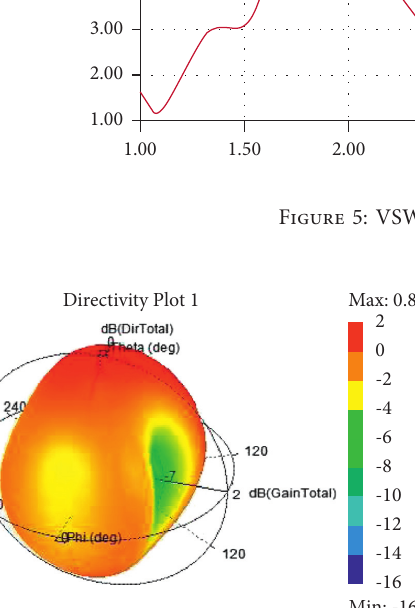
Figure 6: Directivity plot of the proposed design. Figure 7: Gain plot of the proposed